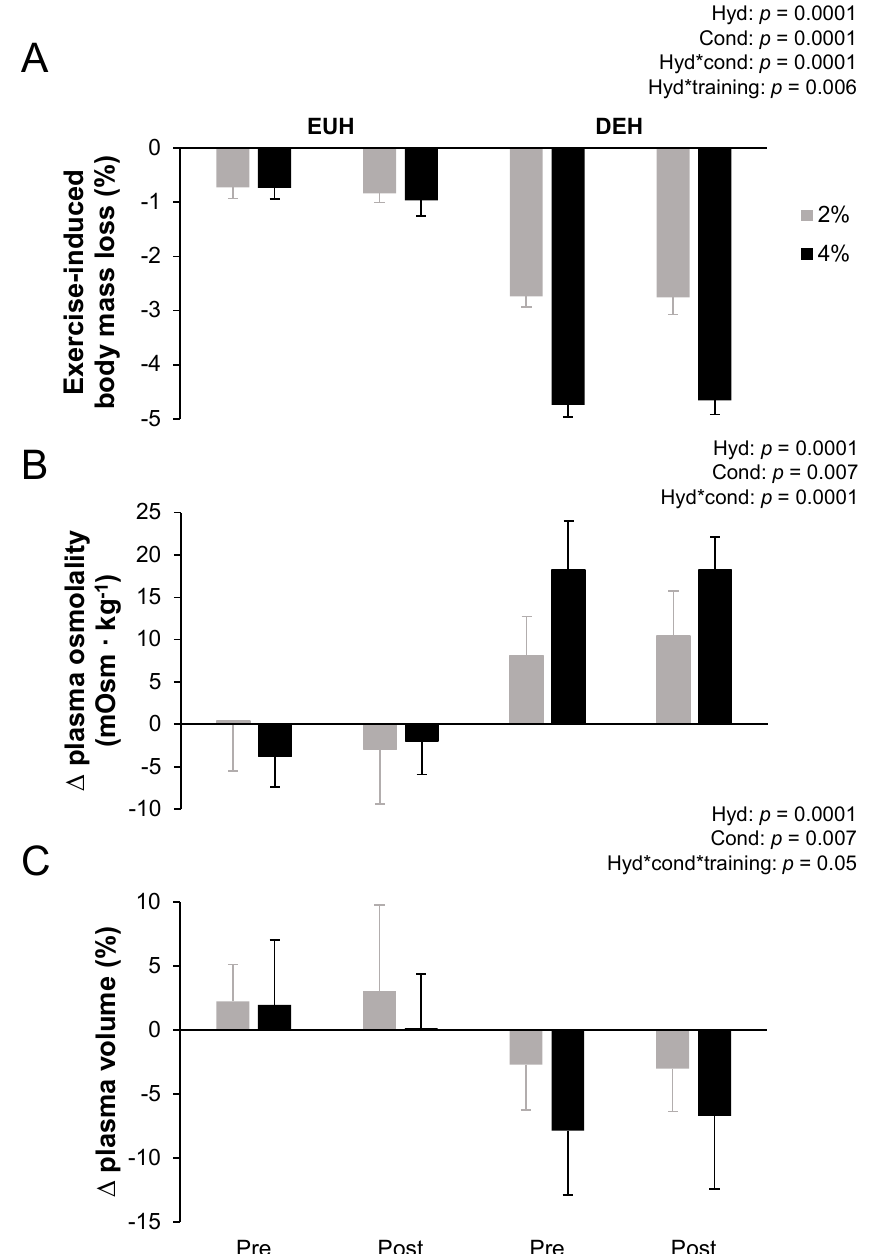
Figure 2. Exercise-induced body mass losses at the end of the 12 min time-trial ( A ) and changes in plasma osmolality ( B ) and plasma volume ( C ) measured at the end of the fixed-intensity exercise periods while replacing or not 2 or 4% body mass losses, pre- and post-training. Δ = difference. Values are the means ± SD. EUH = euhydrated; DEH = dehydrated; Cond = condition (2 vs. 4%); Hyd = hydration (EUH vs. DEH); Training = pre vs. post. Only the significant effects are reported. Pre-exercise plasma aldosterone concentrations were similar across all testing ses- sions (200 ± 109 pg · mL − 1 , all p > 0.05). However, at the end of the preload, plasma aldosterone concentrations were higher with the 4 than the 2% condition ( p = 0.003), with hydration*condition ( p = 0.01) but no hydration ( p = 0.07), training ( p = 0.08), con- dition*training ( p = 0.22), hydration*training ( p = 0.19) or hydration*condition*training ( p = 0.054) effects. Post hoc analyzes revealed that condition effect was present for both, DEH ( p = 0.02) and EUH ( p = 0.04), but that the hydration effect was only present for the 4 (+140 ± 166 pg · mL − 1 , p = 0.03) but not the 2% condition (+25 ± 136 pg · mL − 1 , p =